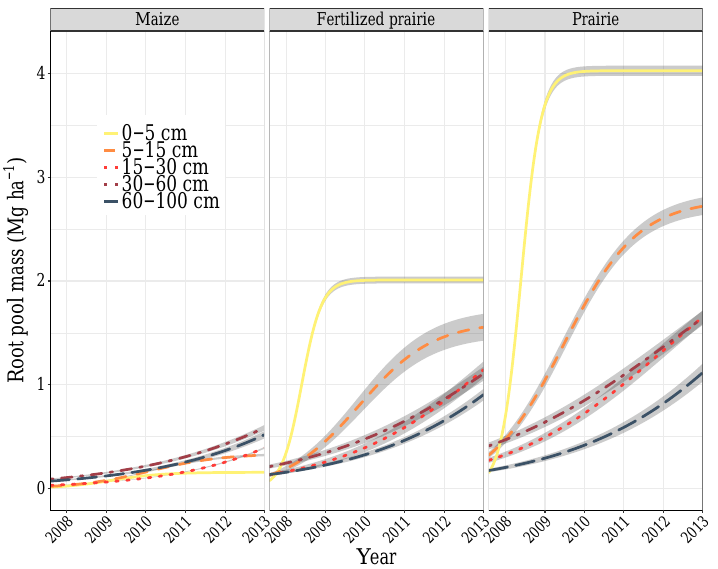
Figure 3. Modeled accumulation of root pool mass over 6 years at 0–5, 5–15, 15–30, 30–60, and 60–100cm. Grey shading represents 1 standard error of the mean. Seasonal effects are